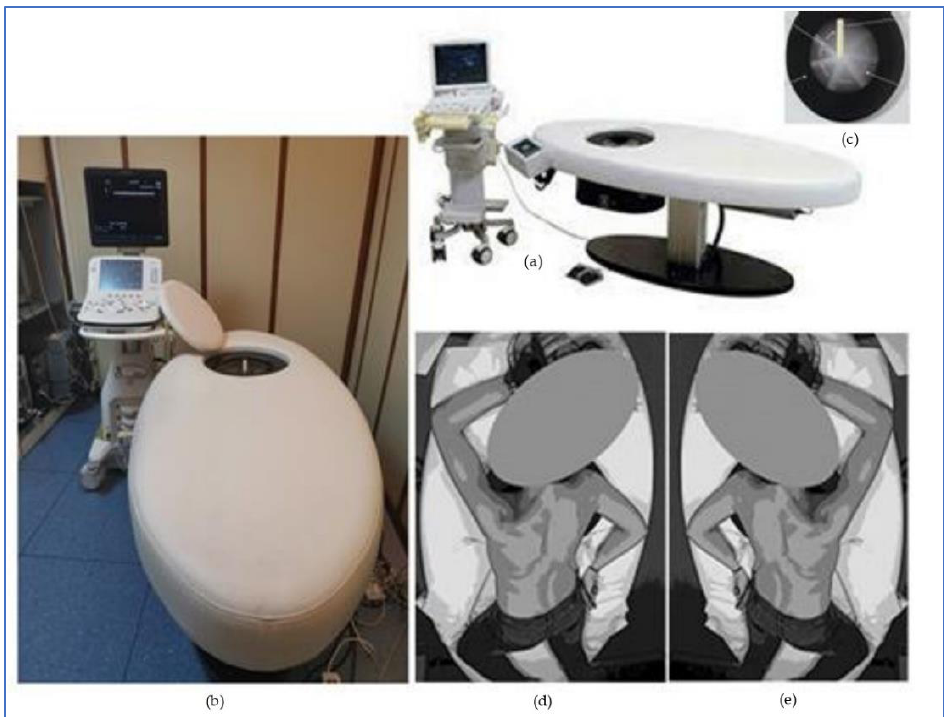
Figure 1. 3D Prone ABUS device and patient optimized positioning. ( a ) 3D Prone ABUS graphic design drawing. ( b ) 3D Prone ABUS hospital device picture. ( c ) Table embedded transducer. ( d ) Right breast optimized patient scanning position. ( e ) Left breast optimized patient scanning position.